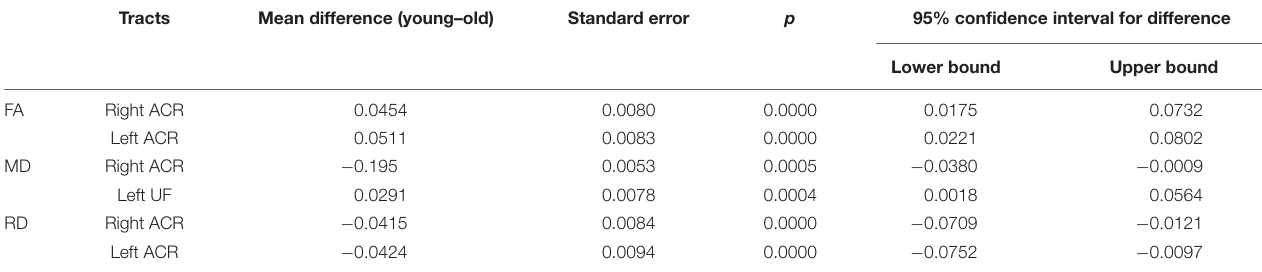
TABLE 2 | Significant difference between DTI metrics and tract by group comparisons. Tracts